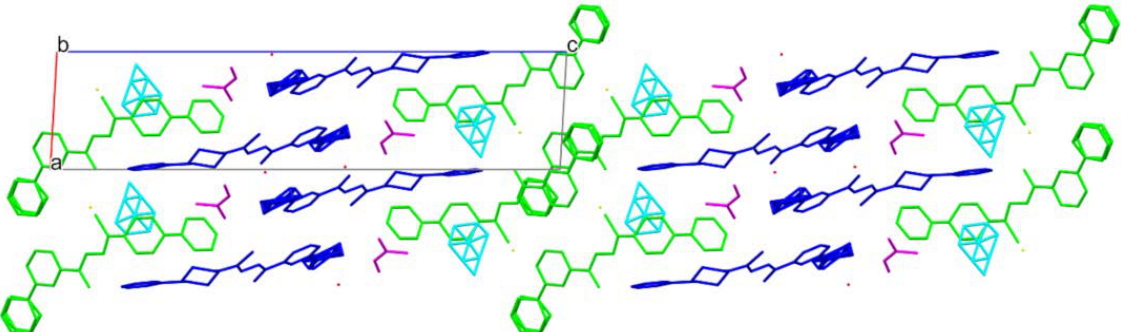
Figure 8. The crystal packing of compound 4 . The molecules of 5 form chains via N3-H3 ··· S1 hydrogen bonds (Table 7, Figure 9) in the studied crystal. Additionally, intramolecular hydrogen bonds (N4-H4B ··· S1) are formed. The molecule fragment ( N ’-thioformylpicolinohydrazonamide) takes a flat form (r.m.s. deviation = 0.0775 Å).